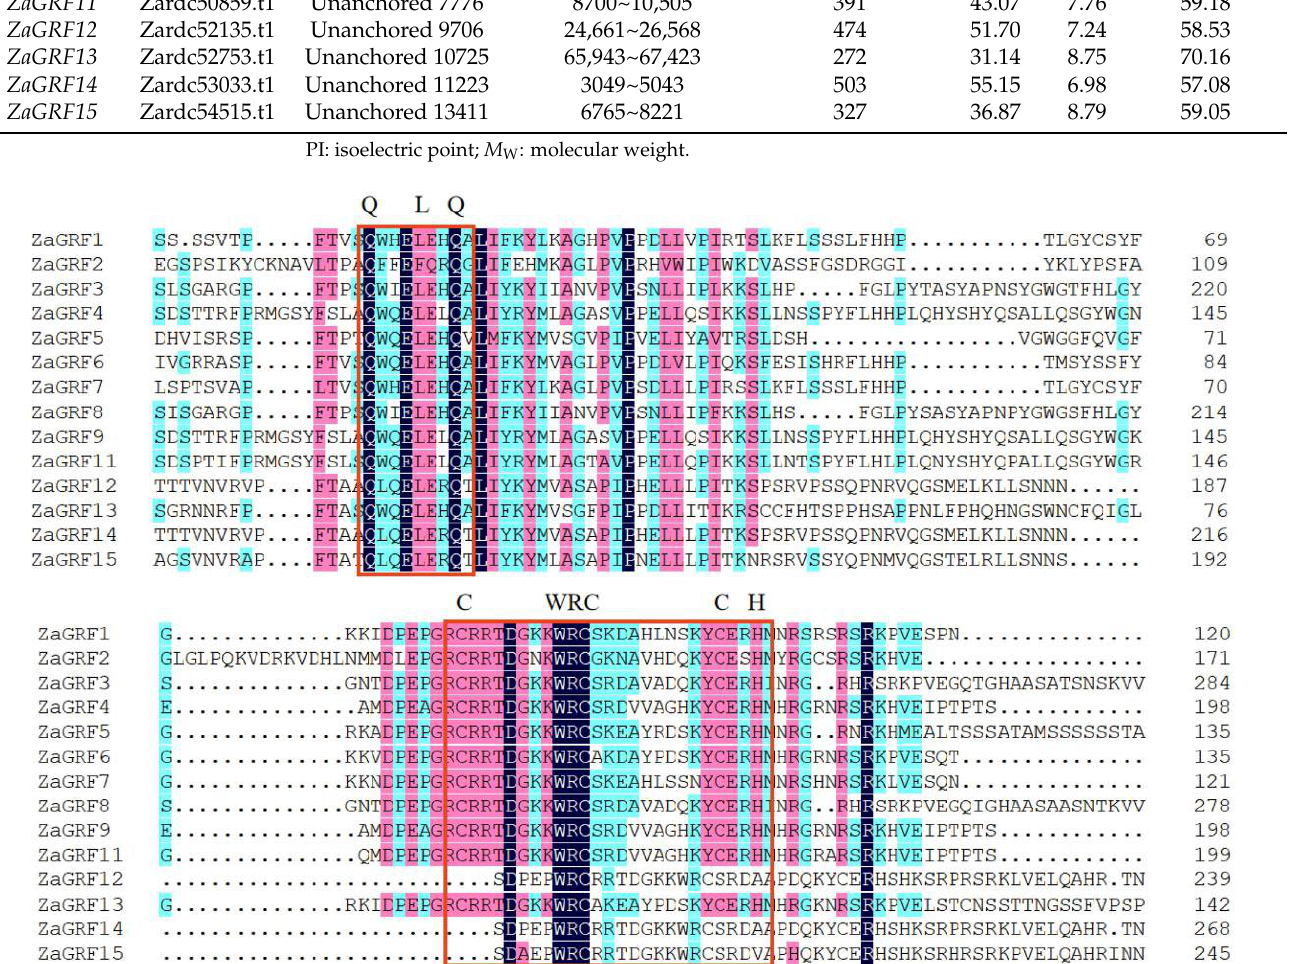
Figure 1. Comparison of multiple amino acid sequences of GRF members of Z. armatum. Different colors indicate different degrees of similarity (black: 100%; pink: >75%; blue: >50%).